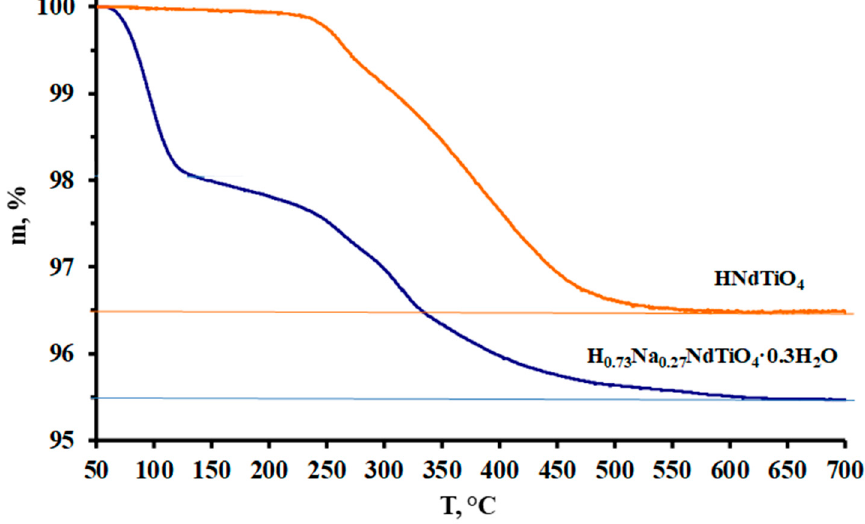
Figure 2. Thermogravimetric (TG) curves of partially and completely protonated samples.